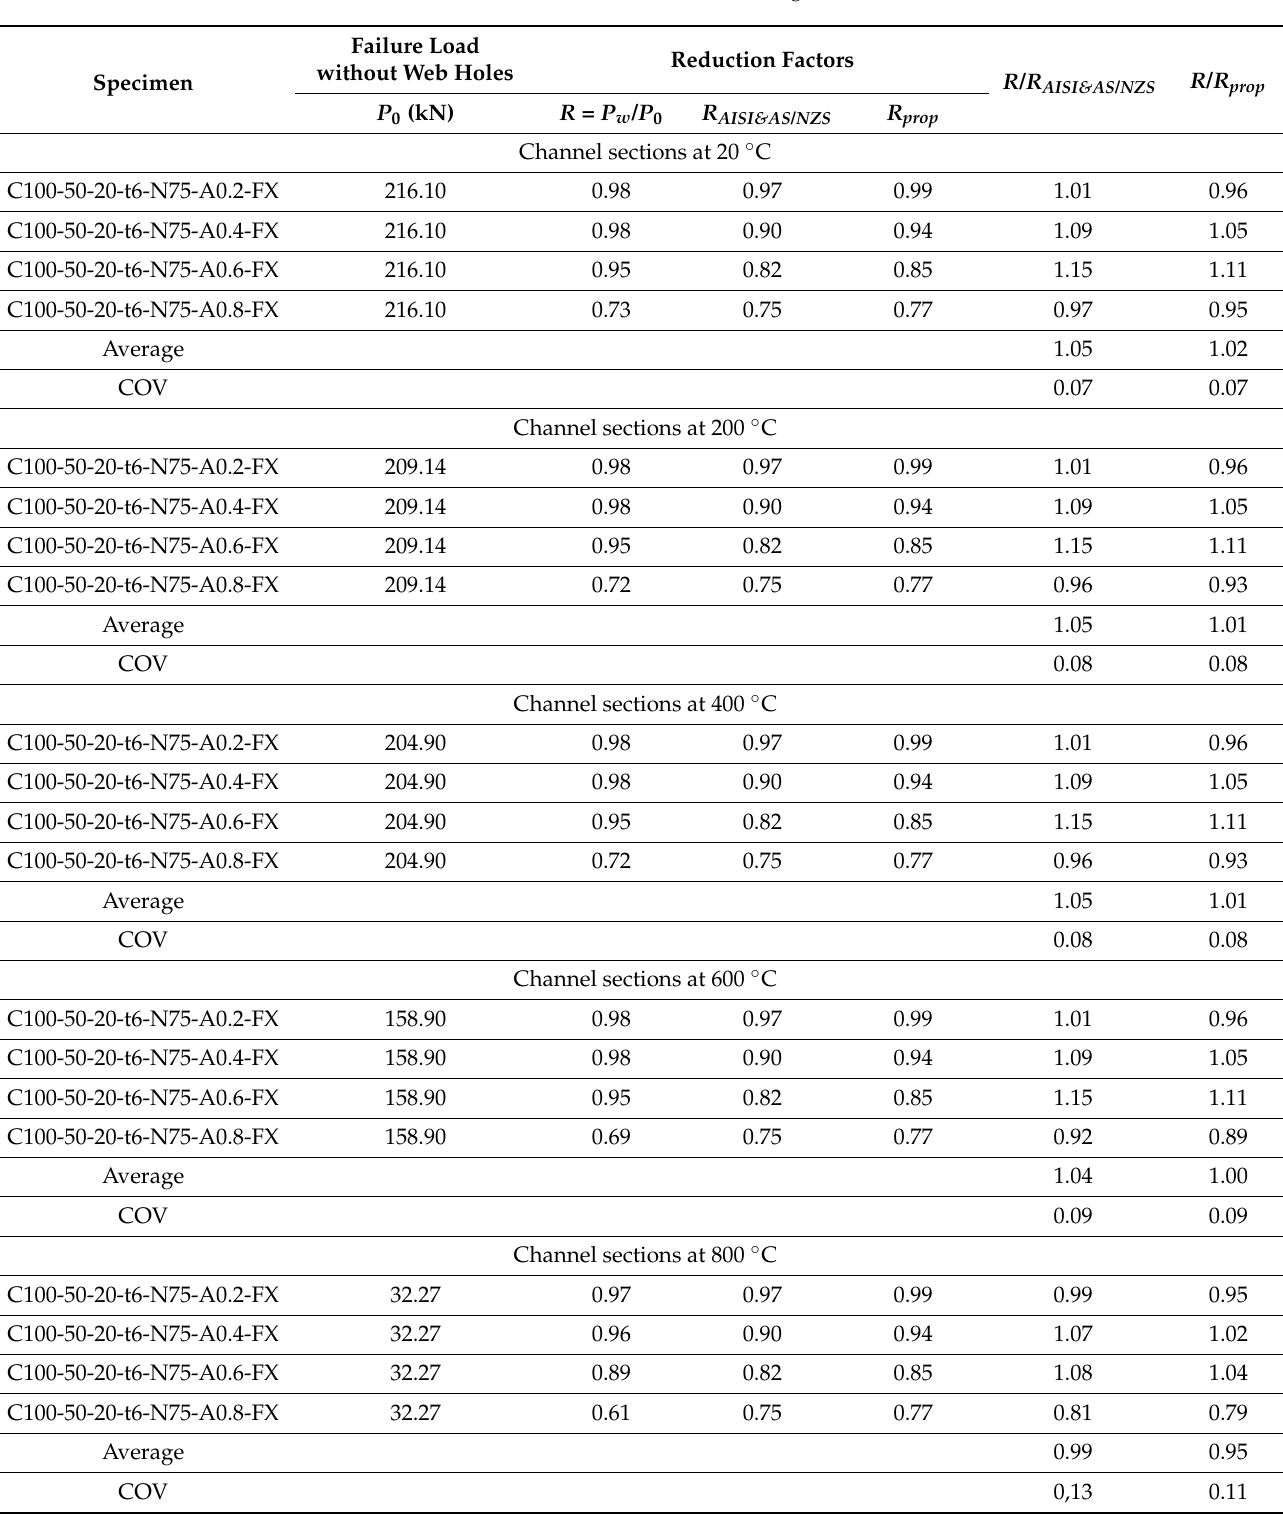
Table 10. Comparison of proposed equations for strength reduction factor ( R ) with other calculation methods for channel sections with fastened